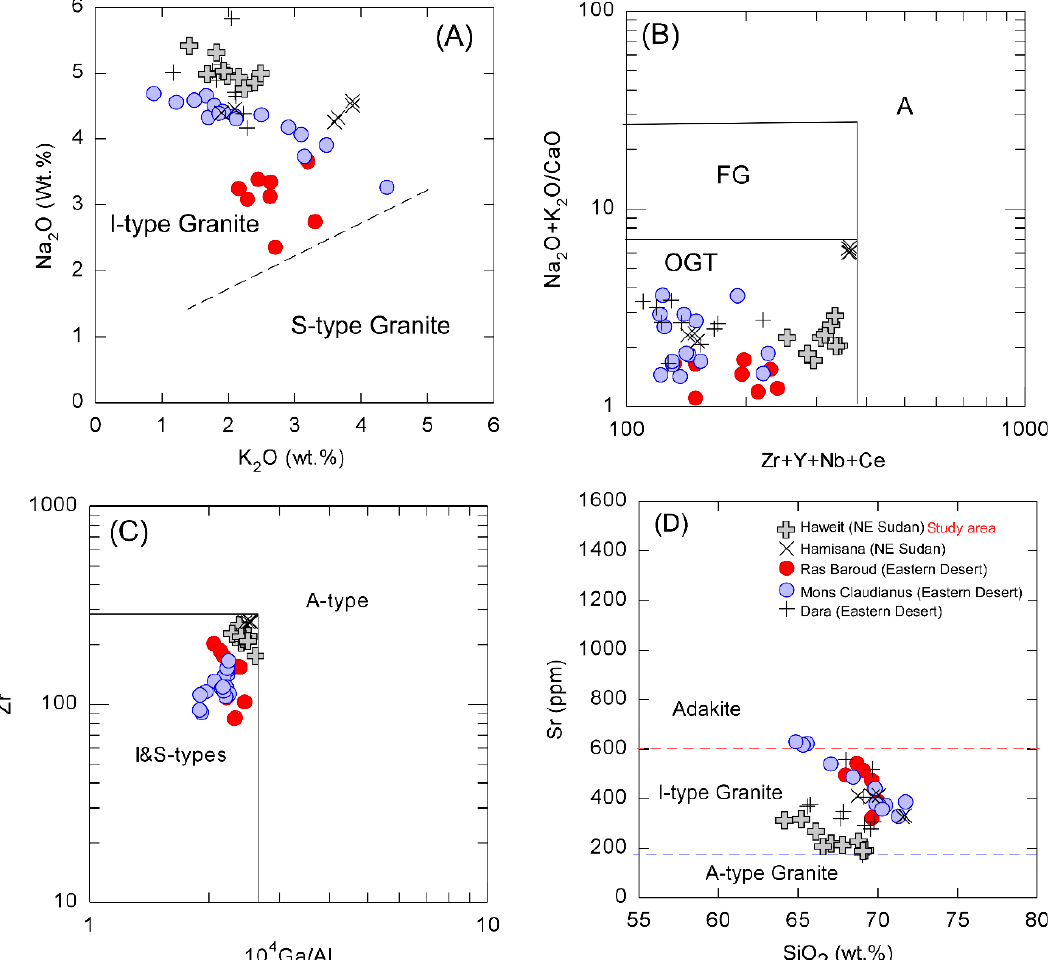
Figure 9. ( A ) K 2 O vs. Na 2 O diagram [56]; ( B ) (K 2 O + Na 2 O)/CaO vs. (Zr + Nb + Ce + Y) and ( C ) Zr (ppm) vs. 10000Ga/Al diagrams of the Haweit granodiorites [57], where A = A-type granite; FG = M + I + S-type fractional granite; OGT = non-fractional M + I + S-type granite; and ( D ) Sr vs. SiO 2 diagram where the A-type, I-type, and adakite division is after Su et al. [58]. The data of other granodiorite samples from various localities in the Nubian Shield, including Hamisana [13], Ras Baroud [41], Mons Claudianus [42], and Dara [43], are used for comparison.